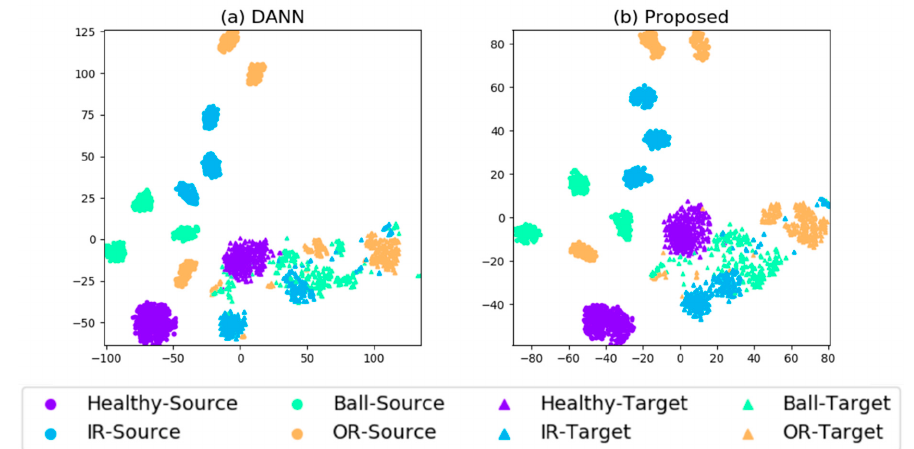
Figure 4. t-SNE results of task ‘CWRU → JNU’ through method ( a ) DANN, ( b ) proposed method. The number of target samples each class is one. Both the features of source domain and target domain are drawn into single images for better visualization. Two shapes represent two domains (square for source domain and circle for target domain), and four colors represent four classes.